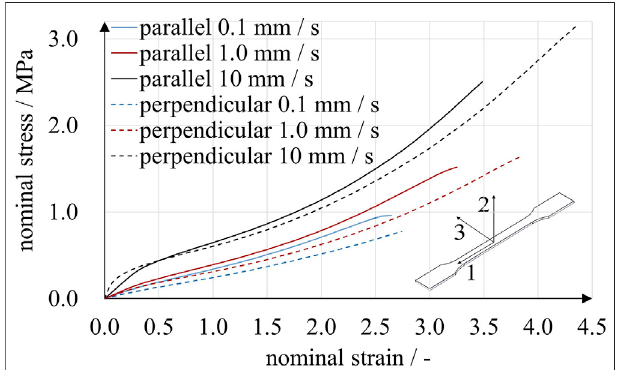
FIGURE 4 | Uniaxial tensile experiments with A30 specimens. Two print directionsand threeloadingrateswere compared.Specimensprinted parallel to the 1-3-plane showed stiffer behavior than those printed perpendicular to the 1-3-plane. Under the given experimental conditions, the stresses observed for a particular strain were affected more by loading rate than by print